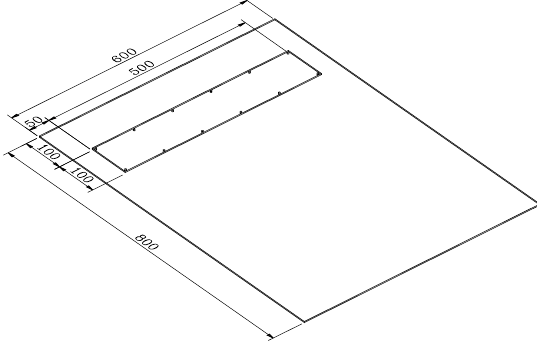
Fig. 7. Coupled structure: plate modified by a reinforcing